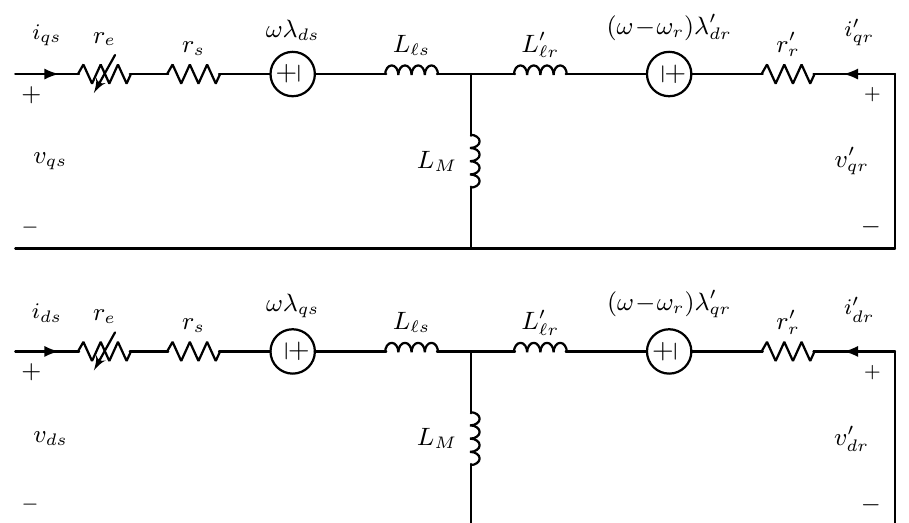
Figure 4. Induction machine equivalent qd 0 circuits with external variable stator resistance r e